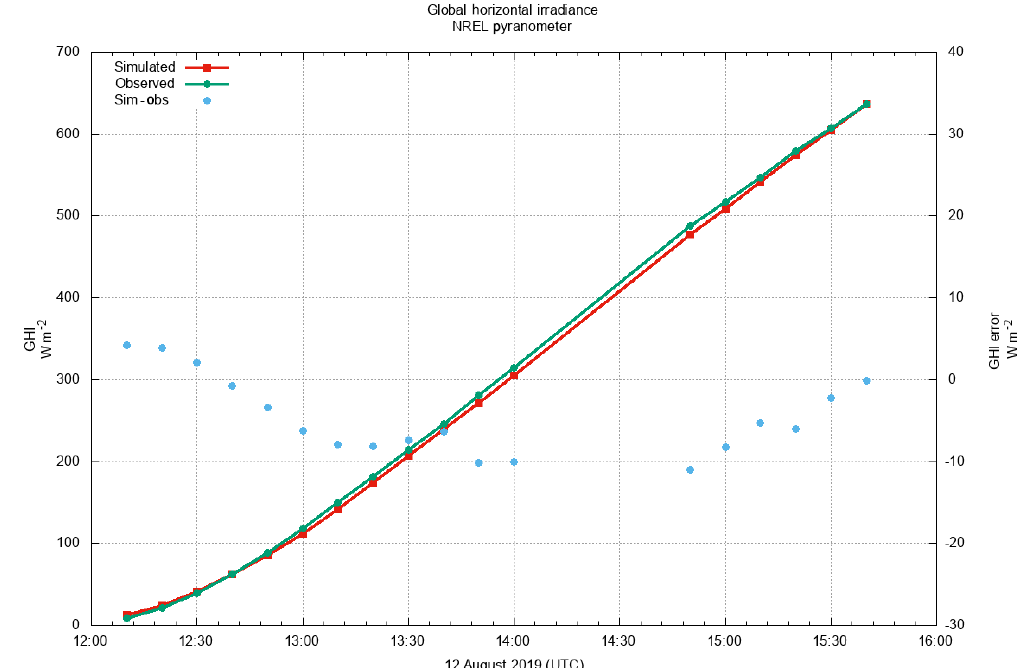
Figure 2. Time series of GHI values integrated from SWIm radiance images (red lines, vertical axis on left) compared with concurrent pyra- nometer observations in watts per square meter at NREL (green lines). The comparison spans a 4h period on the morning of 12 August 2019. Simulated minus pyranometer GHI values are plotted as blue circles (vertical axis on right). Sky conditions were free of significant clouds, with aerosol optical depth